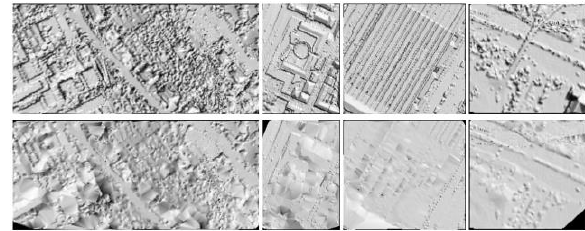
Figure 6. Original (top) and ground-filtered (bottom) data for the highest two (left) and lowest two (right) total errors.